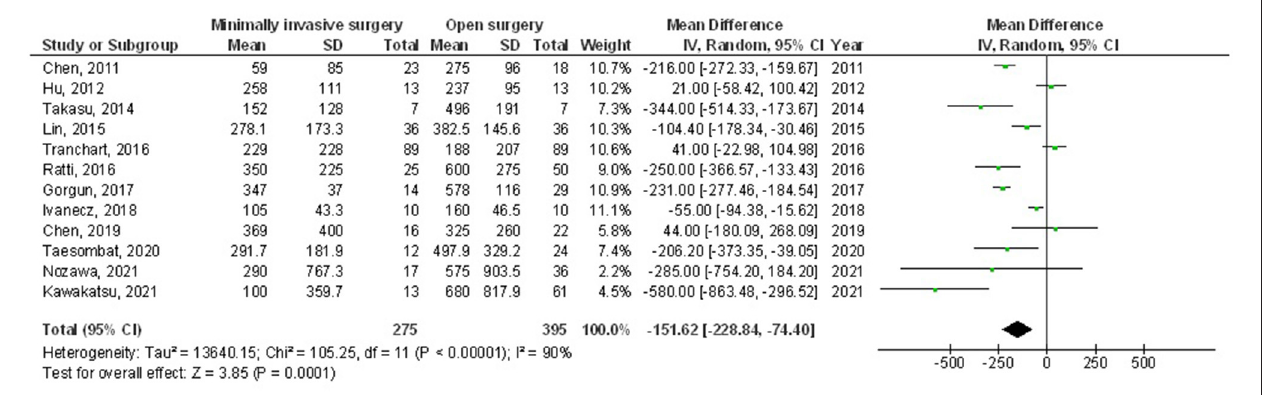
FIGURE 7 | Forest plot of the effect of minimally invasive surgery compared to open surgery on overall survival in subjects with colorectal cancer and synchronous colorectal liver metastases.